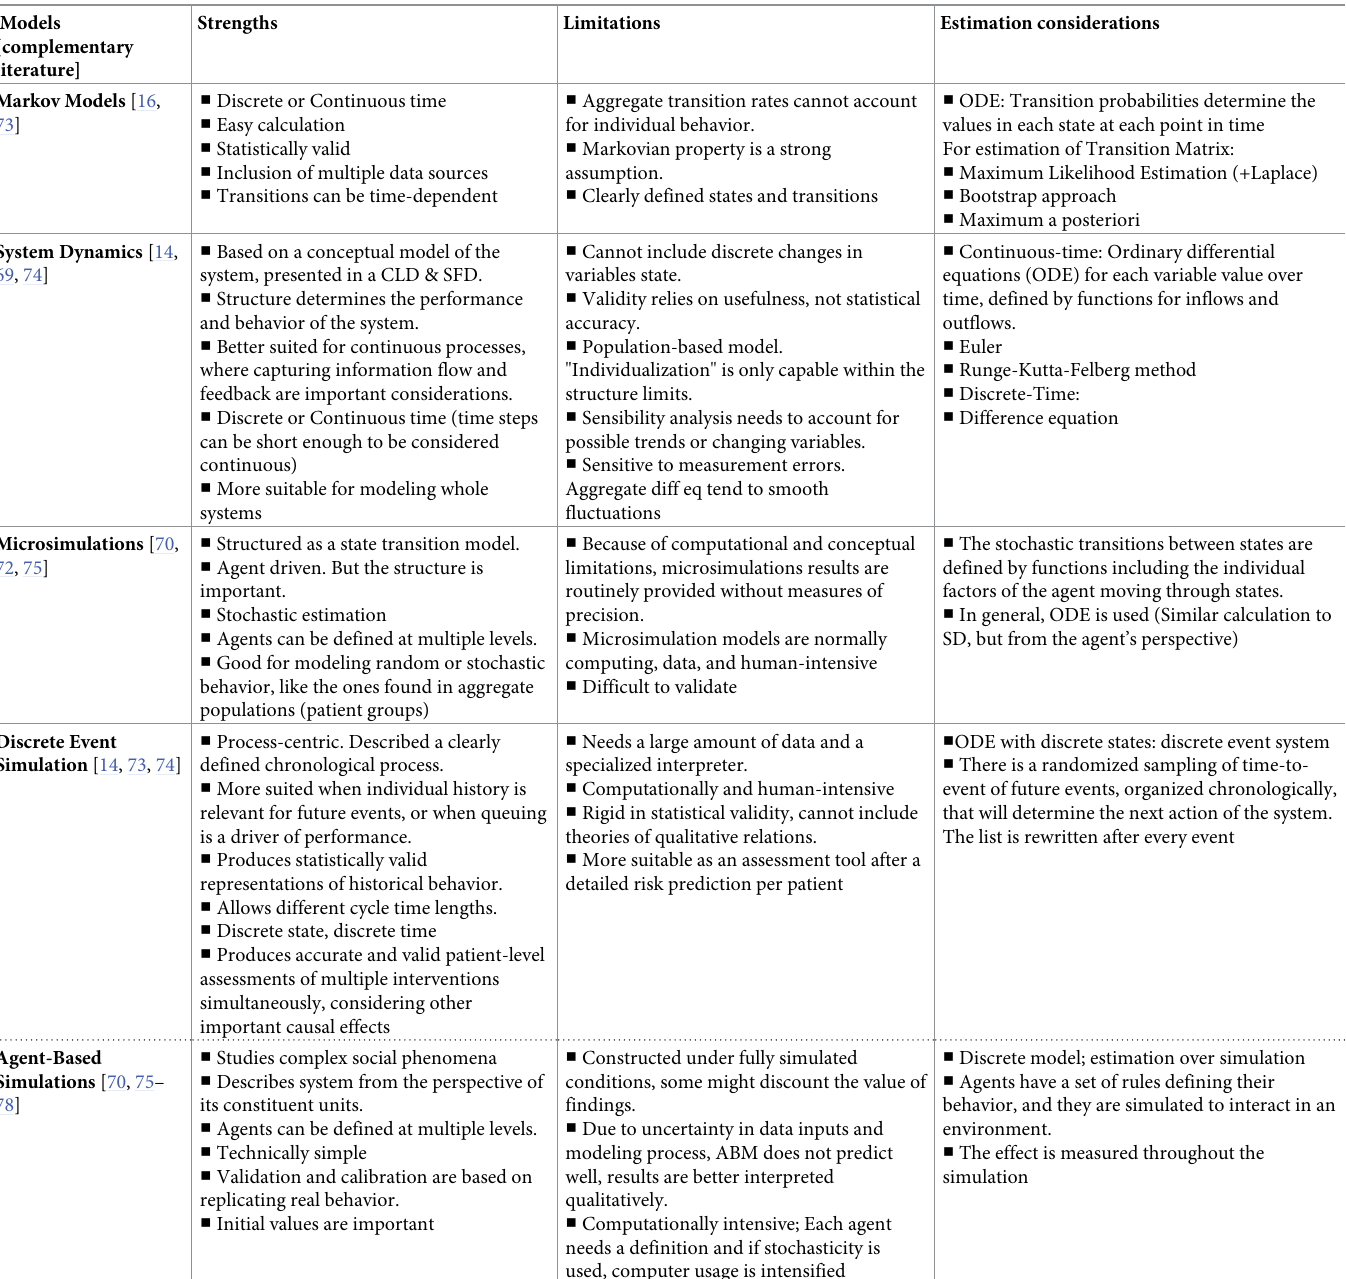
Table 2. Summary descriptions of simulation modeling